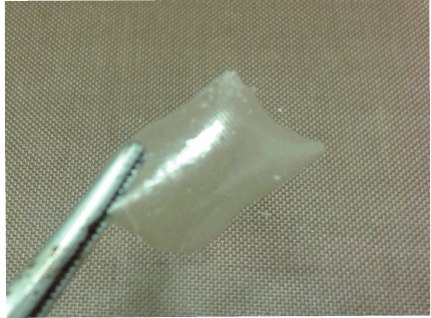
Figure 4: The visual appearance of films produced with HCl as catalyst agent.